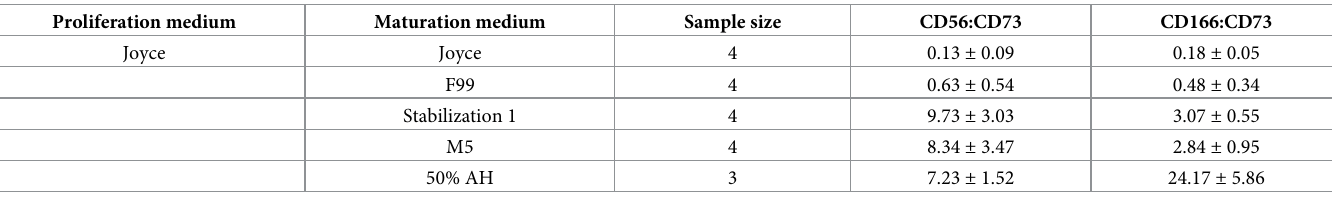
To evaluate the effect of human aqueous humor on HCEC characteristics compared to the cul- ture conditions identified above, HCECs (n = 3) were proliferated in Joyce’s medium and matured in human endothelial-SFM containing 50% human aqueous humor. HCEC lines matured in 50% aqueous humor showed variable cell density but all cultures showed a uniform monolayer with hexagonal-like shaped cells (Fig 1B). Average CD56:CD73 and CD166:CD73 ratios were 7.23 ± 1.52 and 24.17 ± 5.86 in cells matured in 50% aqueous humor (Table 3). Similar CD56:CD73 expression ratios were found in HCECs proliferated in Joyce’s medium and matured in either Stabilization 1 or M5 medium (p = 0.55). CD166:CD73 ratios in cells matured in 50% aqueous humor were greater than cells treated with other maturation condi- tions (F99, Stabilization 1, M5) (p < 0.001).